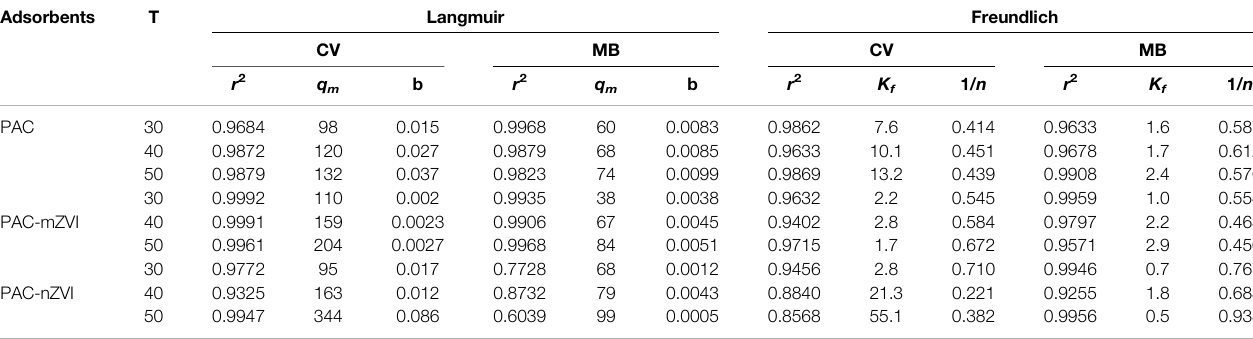
TABLE 4 | Parameters for the adsorption isotherms of CV and MB on PAC and PAC-based ZVI adsorbents. Adsorbents